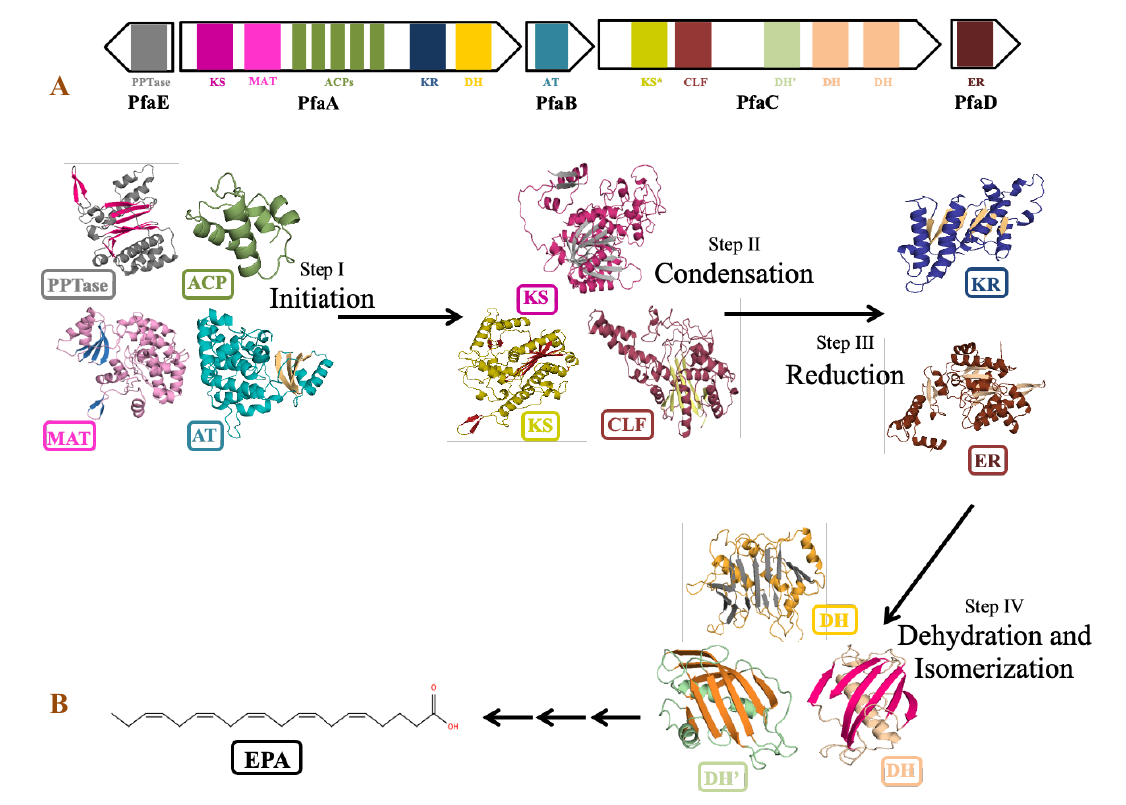
Figure 8. Domain organization and role of catalytic domains of EPA biosynthetic gene cluster of Shewanella sp. N2AIL in PUFA synthesis. ( A ) The catalytic domains are organized in five open reading frames (ORFs) represented in the form of arrows and the domains are represented in the form of differently colored solid blocks. ( B ) The major steps in EPA biosynthesis include: (i) initiation involving activation of acyl carrier proteins (ACP) by phosphopantetheine transferase (PPTase) which carries acyl and malonyl substrates transferred by acyltransferase (AT) and malonyl CoA:ACP acyl transferase (MAT) domains for fatty acyl chain elongation, followed by several cycles of (ii) con- densation involving ketoacyl synthase (KS) and chain length factor (CLF) domains, (iii) reduction by ketoacyl-ACP reductase (KR) domain and (iv) dehydration by dehydratase (DH) domain and FabA-type dehydratase. Finally, elongation process is completed by reduction of double bond by enoyl reductase